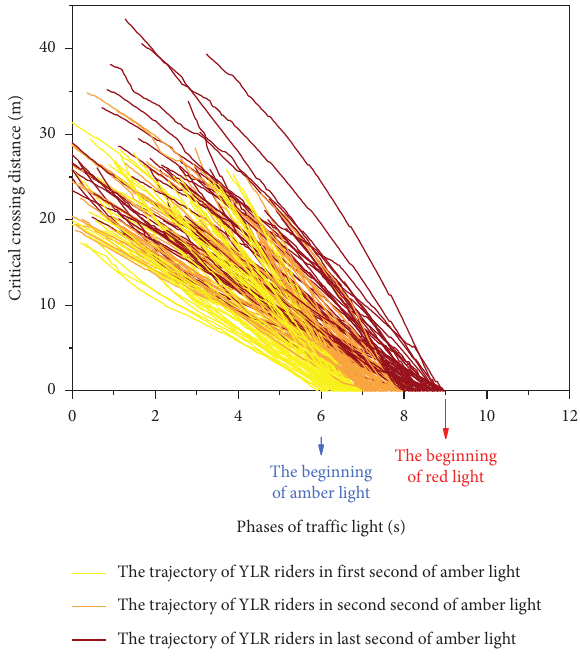
Figure 5: YLR e-biker’s trajectories at the intersection.